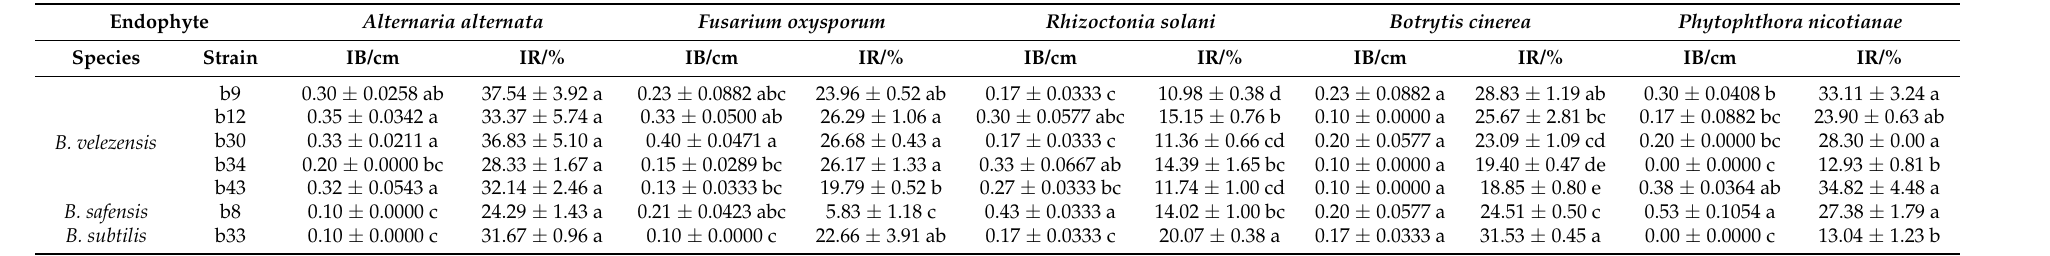
Table 4. Inhibiting effects of apple endophytic bacteria on fungal pathogens of